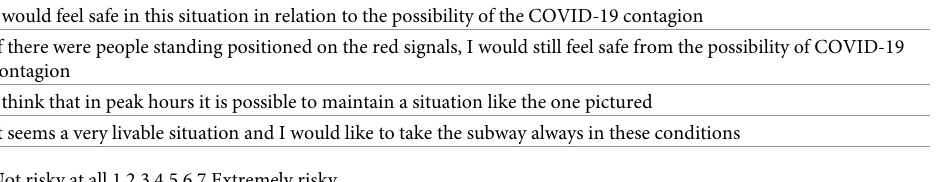
Table 3. The second subscale of risk perception.